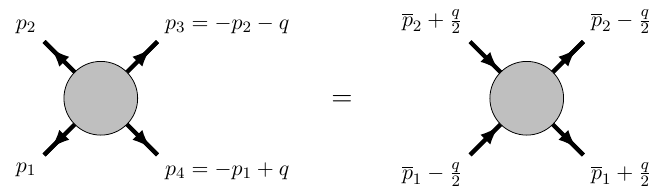
Figure 1 . Parametrization of external